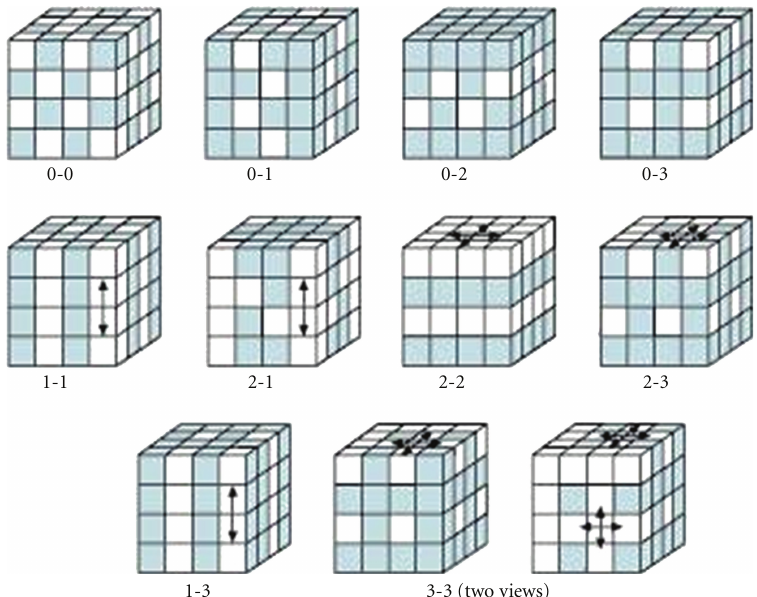
Figure 1: Di ff erent types of connectivity of the two-phase composite system [28,